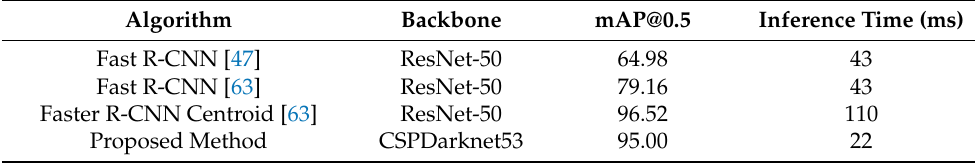
Table 2. Accuracy (mAP@0.5) comparison between this paper’s method and those of